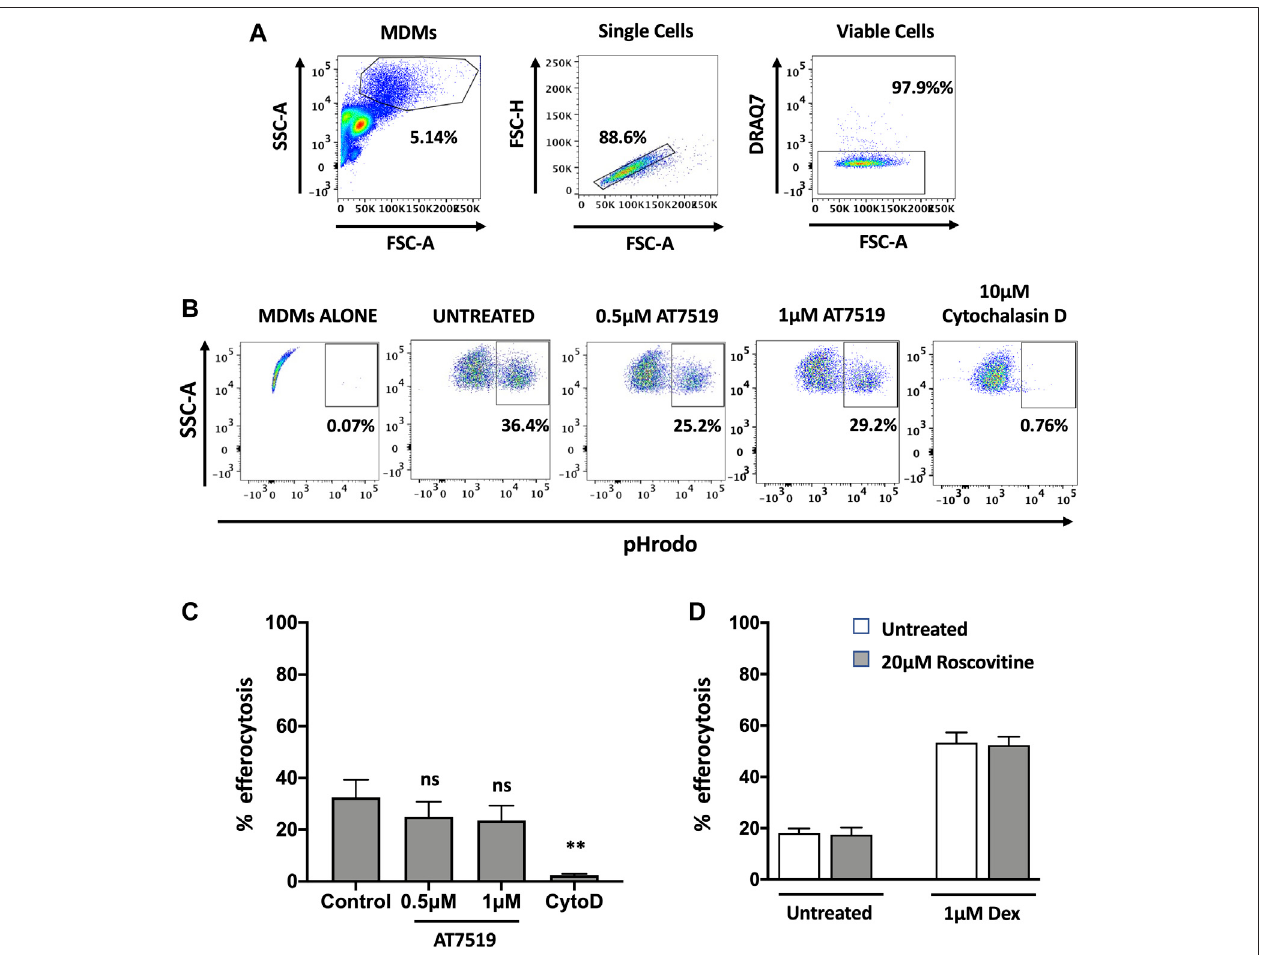
FIGURE 4 | Pharmacological inhibition of MDMs with AT7519 does not affect macrophage initial efferocytosis. (A) Gating strategy used for the analysis of MDMs, analysing viable single cells from the MDM population. (B) Representative fl ow cytometry plots depicting the effects of AT7519 pre-treatment on macrophage efferocytosis of pHrodo labelled apoptotic neutrophils at a 1 h timepoint. Macrophages that had undergone efferocytosis are shown as pHrodo positive. (C) Collated levels of efferocytosis at 1 h timepoint from all donors tested, comparing control treated MDMs to MDMs treated with 0.5 µM or 1µM AT7519, or 10 µM Cytochalasin D (Cyto D). (D) Quantitation of efferocytosis at 1 h timepoint of apoptotic neutrophils in MDMs treated ± 20 µM Roscovitine, +/ − 1 µM Dexamethasone. Data represent means ± SEM from n = 6 separate donors, ** p < 0.01. ns = no signi fi cant difference.